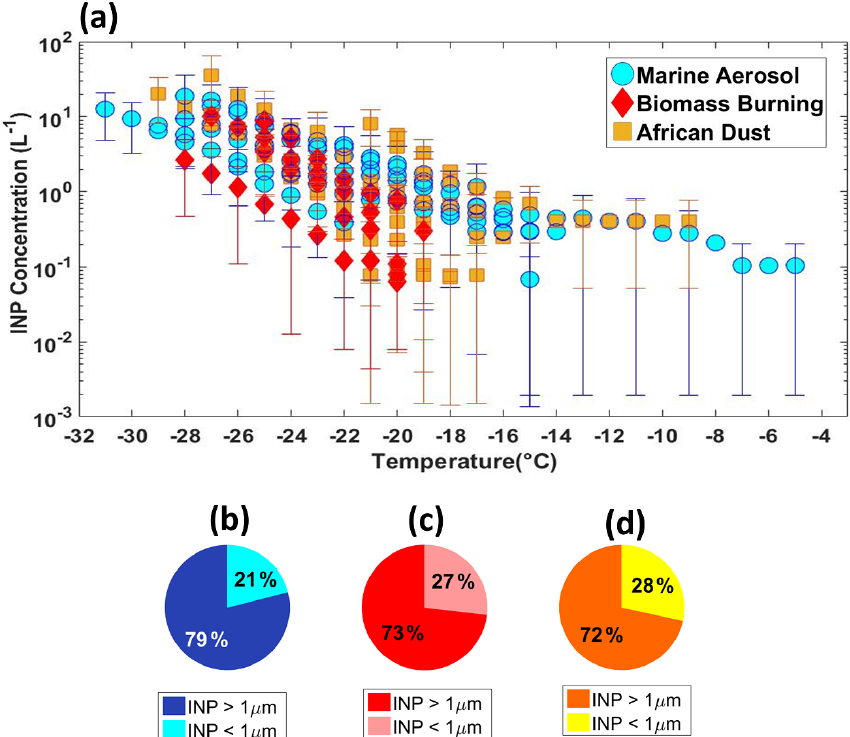
Figure 7. (a) INP concentrations as a function of temperature for MA (cyan circles), AD (yellow squares), and BB (red diamonds) for aerosol particles with sizes ranging between 0.32 and 10µm. The pie charts illustrate the contribution of supermicron and submicron particles to the total INP concentrations for (b) MA, (c) BB, and (d)